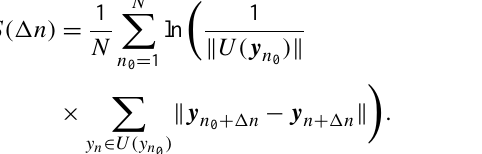
Fig. 6. The curve of S (∆ n ) for embedding dimensions m =14 , 15 . The maximum Lyapunov exponent of the time series is the slope of the dashed line 0 . 15 0 . 006 . ±